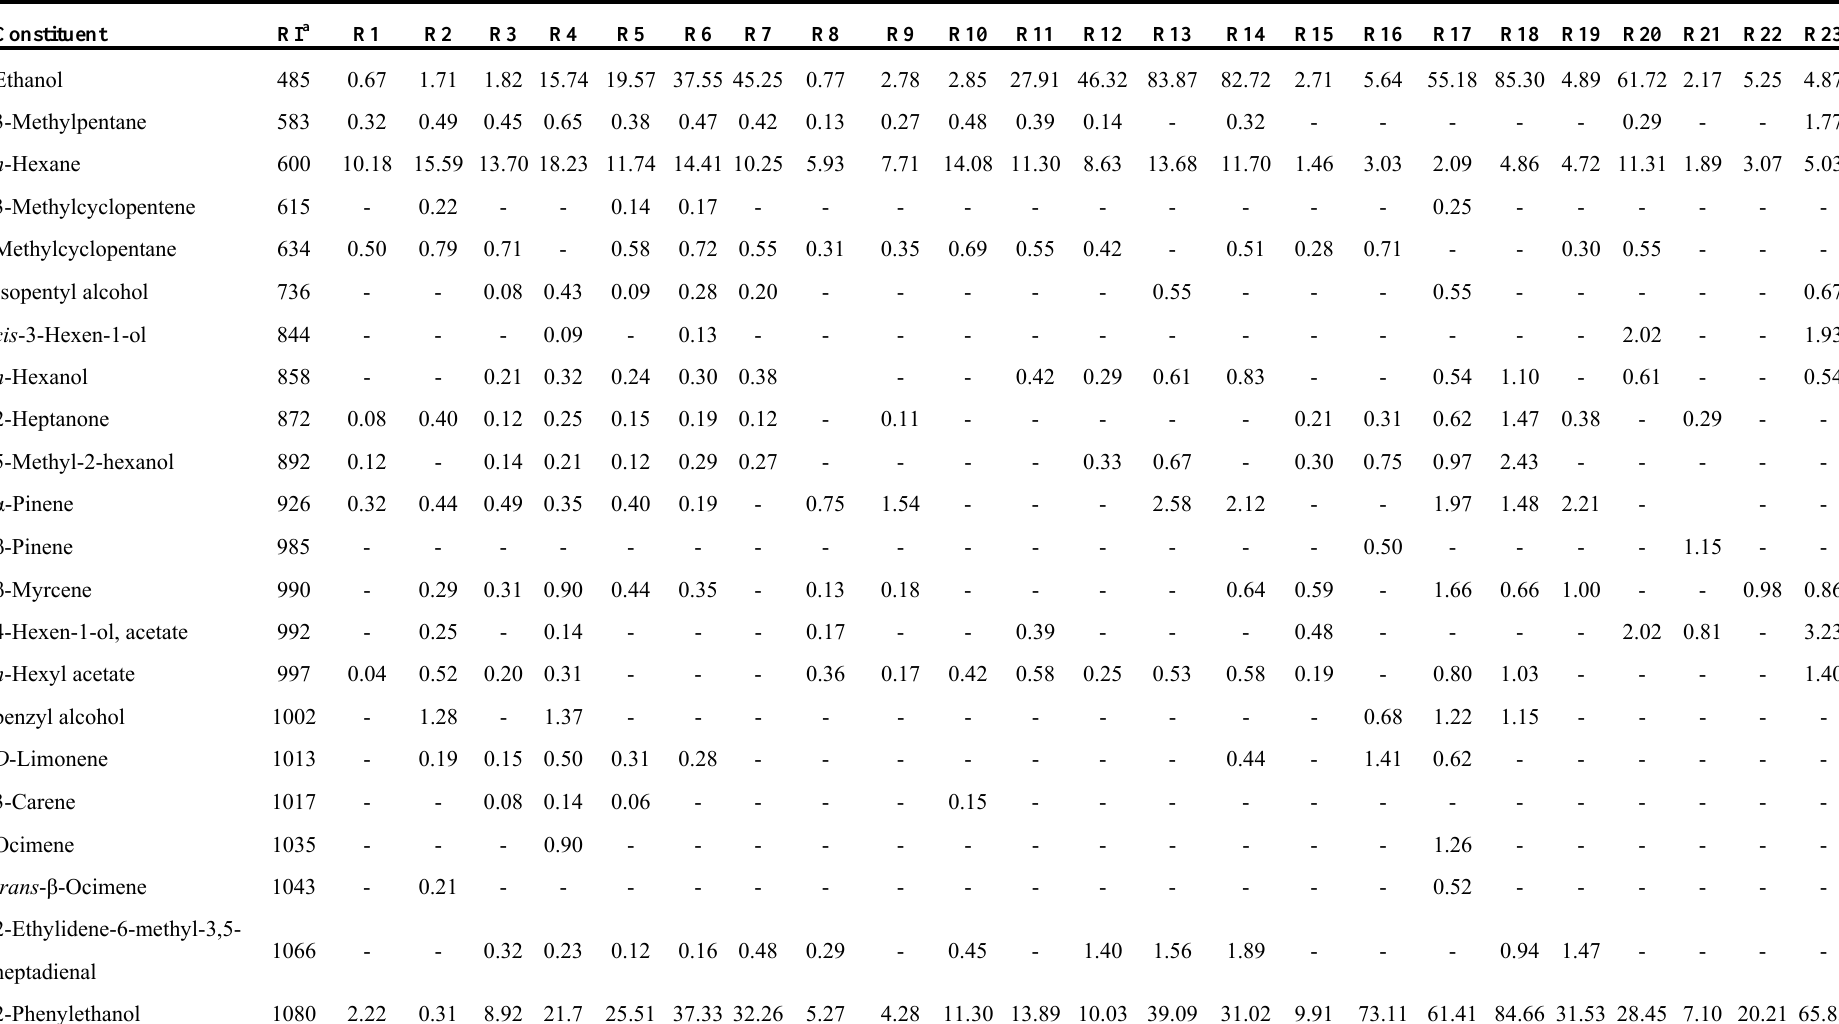
Table 2. Headspace constituents and their content of the different R. rugosa germplasms ( μ g·g -1